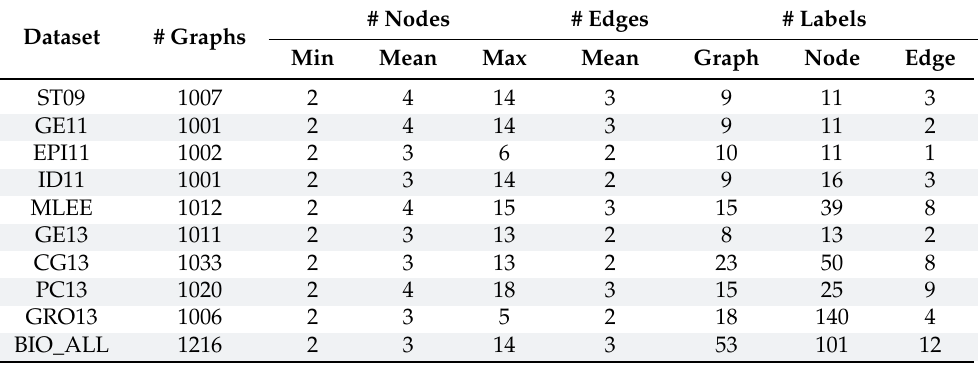
Table 1. Descriptive statistics for sampled datasets. The first column lists the examined datasets. The second column indicates the number of event graph instances (nested events count one), while the third and fourth macro-columns detail the size of events in terms of nodes and edges. Finally, the last macro-column refers to the distinct number of types for events (triggers), entities, and argument roles in each dataset, thus marking the number of possible classes for graphs, nodes, and edges.